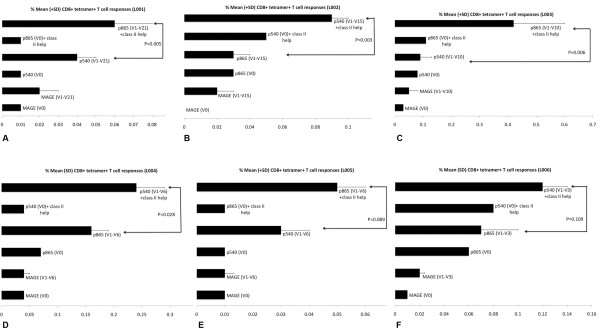
A, B, C and D. Post-vaccination tetramer analysis with DCT pulsed with class I ± class II hTERT. tetramer+ CD8+T cell responses (mean +/- SD) to DCTs pulsed with class I hTERT epitope alone compared with or without class II epitopes from patients L001–L004; E and F. Responses were higher and statistically significant (p < 0.05) in patients L001, L002, L003 and L004; Responses were higher with class II epitopes but not significant (NS) statistically in patients L005 and L006 (p = 0.089 and p = 0.109) when analysed using the independent t-test. Each histogram represents either baseline (V0) tetramer response or mean (SD) tetramer responses assessed over multiple time points as indicated in the parethesis (V1-Vx; Vx being the last vaccination time point). CD8+T cell tetramer+ response to an irrelevant HLA*A201 MAGE antigen, not used in the vaccination, was measured as a negative control; 150,000 events were acquired and analysed.